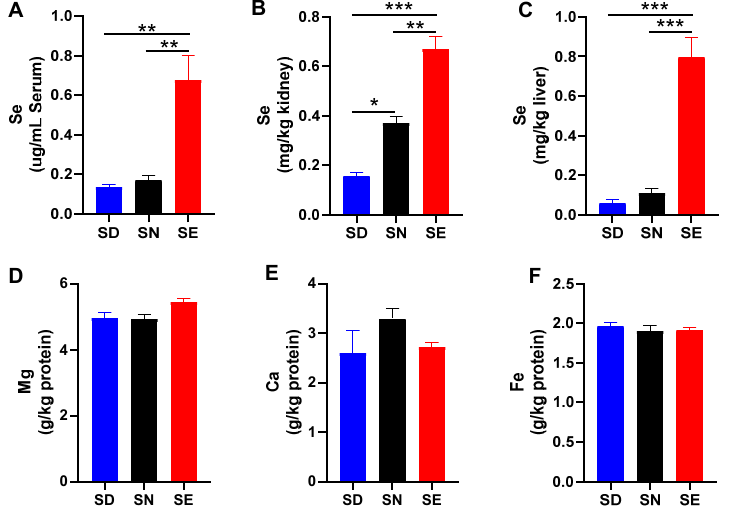
Figure 1. Selenium levels in serum ( A ), kidney ( B ), and liver ( C ), and magnesium ( D ), calcium ( E ), and iron levels ( F ) in kidney from the mice fed with diet containing various amounts of selenium. Values were presented as mean ± SEM; *, p < 0.05; **, p < 0.01; ***, p < 0.001; one-way ANOVA, n = 3. SD, selenium-deficient; SN, selenium-normal; SE, selenium-enriched.